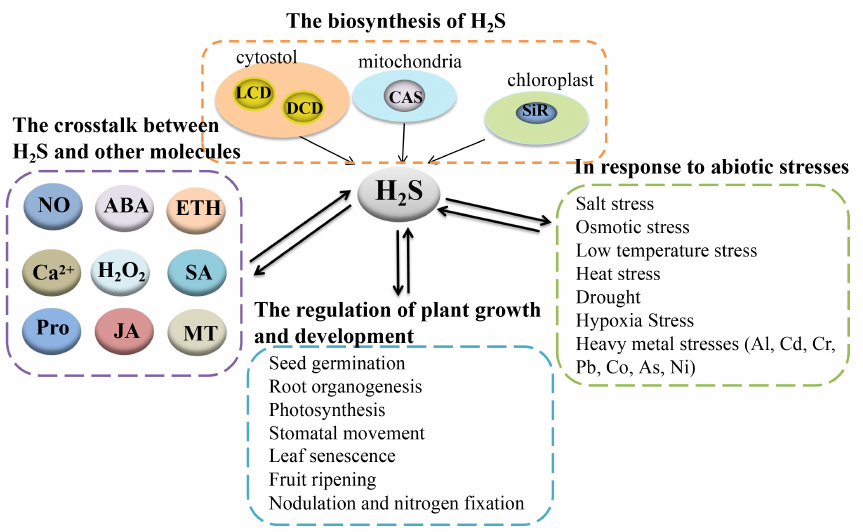
Figure 1. The summary of the biosynthesis of H 2 S, the crosstalk between H 2 S and other molecules, the regulation of plant growth and development, and the response to abiotic stresses by H 2 S. H 2 S, hydrogen sulfide; LCD, L-cysteine desulfhydrase; DCD, D-cysteine desulfhydrase; CAS, β -cyanoalanine synthase; SiR, sulfite reductase; NO, nitric oxide; ABA, abscisic acid; Ca 2+ , calcium ion; H 2 O 2 , hydrogen peroxide; SA, salicylic acid; JA, jasmonic acid; Pro, proline; MT, melatonin; Al, aluminum; Cd, cadmium; Cr, chromium; Pb, lead; Co, cobalt; As, arsenic; Ni, nickel.